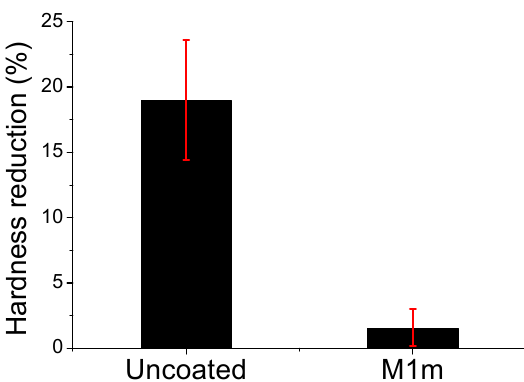
Figure 10. The percentage reduction of hardness in respect to the original concrete hardness of the coated (by M1m) and the uncoated concrete specimens, sprayed with sulfuric acid solution (4 M) by using daily the 17% of the respective reaction’s stoichiometry. The bar charts and the red error bars denote the mean and the standard deviation, respectively.